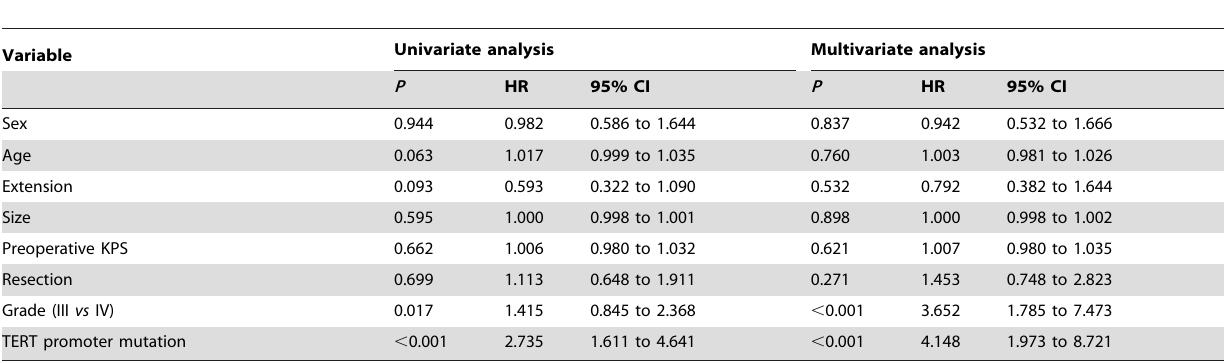
Table 2. Univariate and Multivariate Analysis of Different Prognostic Parameters for Overall Survival of High-grade Glioma Patients.